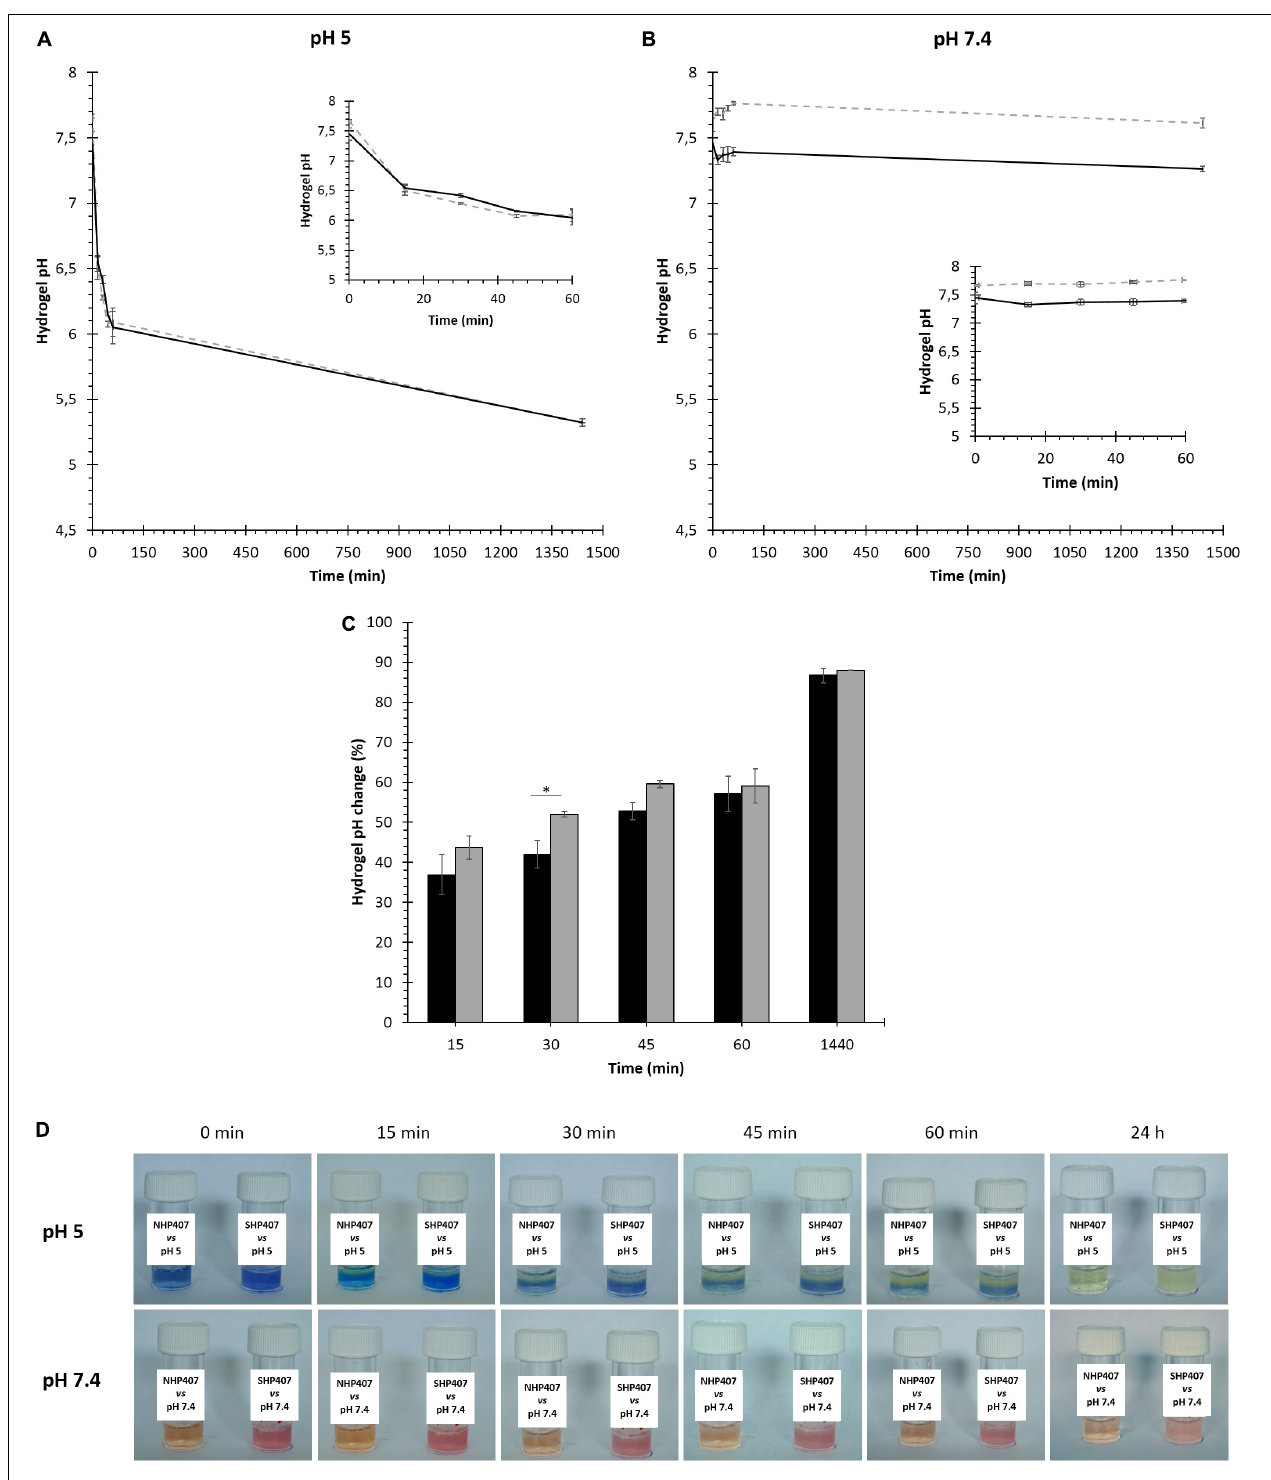
FIGURE 2 | Sensitivity of NHP407- and SHP407-based gels to environmental pH (pH 5 and 7.4). (A,B) NHP407 (black, continuous line) and SHP407 (gray, dashed line) hydrogel pH values after incubation in buffered solutions at pH 5 or 7.4 for different time intervals. Magnified inserts evidence the trend of hydrogel pH within the first 60 min incubation in aqueous medium. (C) Percentage of pH change (evaluated according to Eq. 1) in NHP407- (black) and SHP407- (gray) based hydrogels upon incubation in the presence of acetate buffer at pH 5 for different time intervals. (D) Representative images of NHP407 and SHP407 gels containing pH indicators (phenol red for neutral/basic pH and bromocresol purple for acid pH) which change their color in response to pH changes. Gels were soaked in acetate buffer solution at pH 5 or phosphate buffered solution at pH 7.4 for different time intervals.